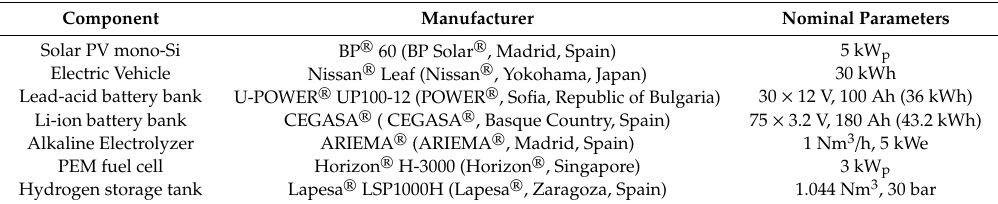
Table 2. Technical characteristics of the subsystems that make up the